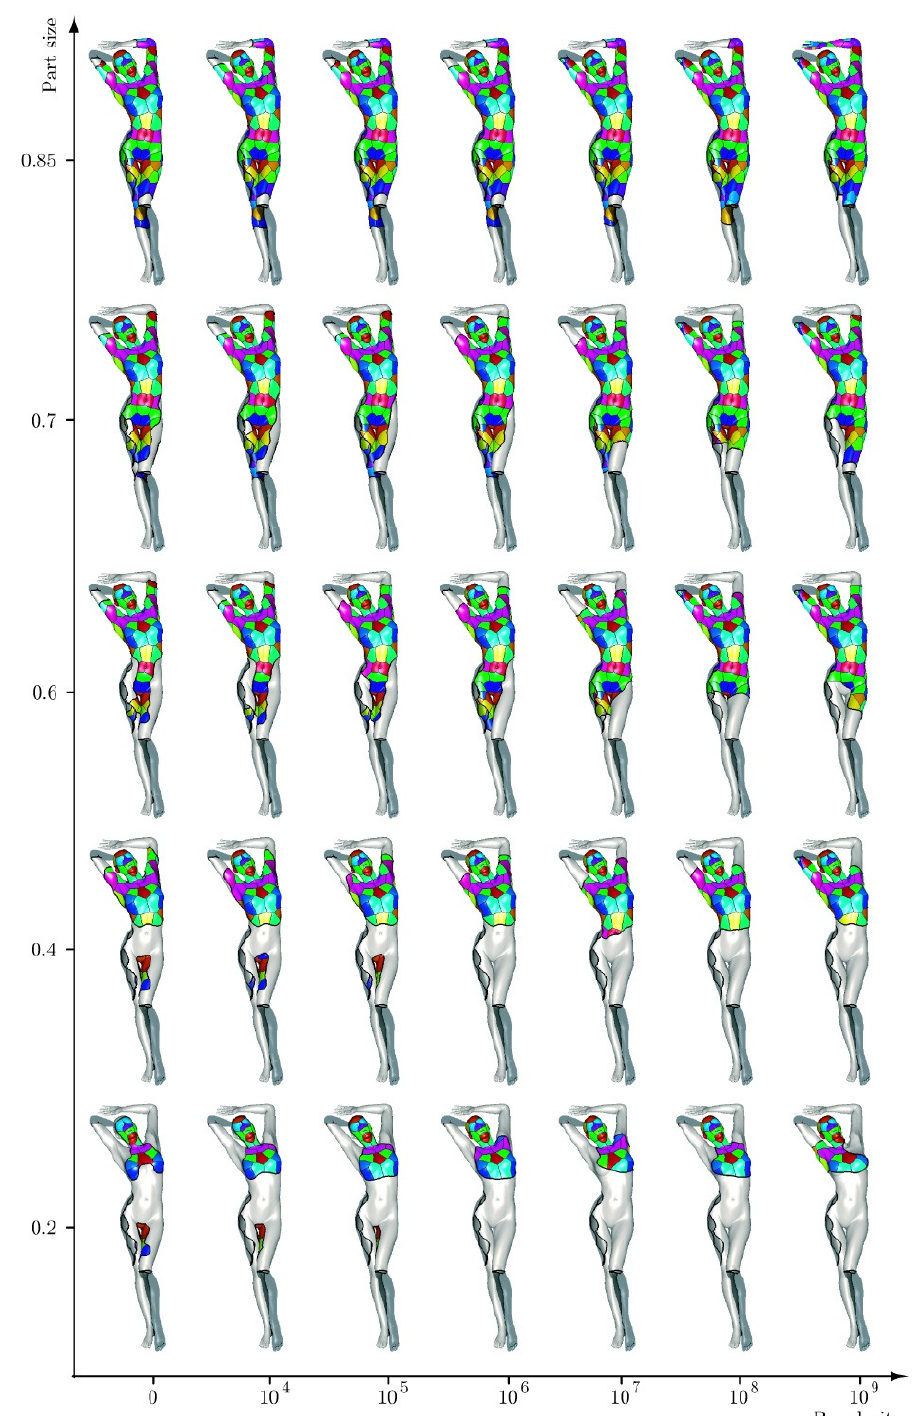
Figure 26. The figure shows exemplary results on partial symmetries of human body models. The partial human body models are obtained by removing certain body parts, and the removed body parts are marked in semitransparent dark gray. The experiments are carried out under various regularization coefficients (the horizontal axis) and various body part sizes (the vertical axis). Symmetric body parts are marked with the same color. Discarded body parts are marked in light gray [84]. Reprinted by permission from SPRINGER NATURE: Springer Nature, Int. J. Comput. Vis., Full and Partial Symmetries of Non-rigid Shapes, D. Raviv, A. M. Bronstein, M. M. Bronstein, R. Kimmel, Copyright